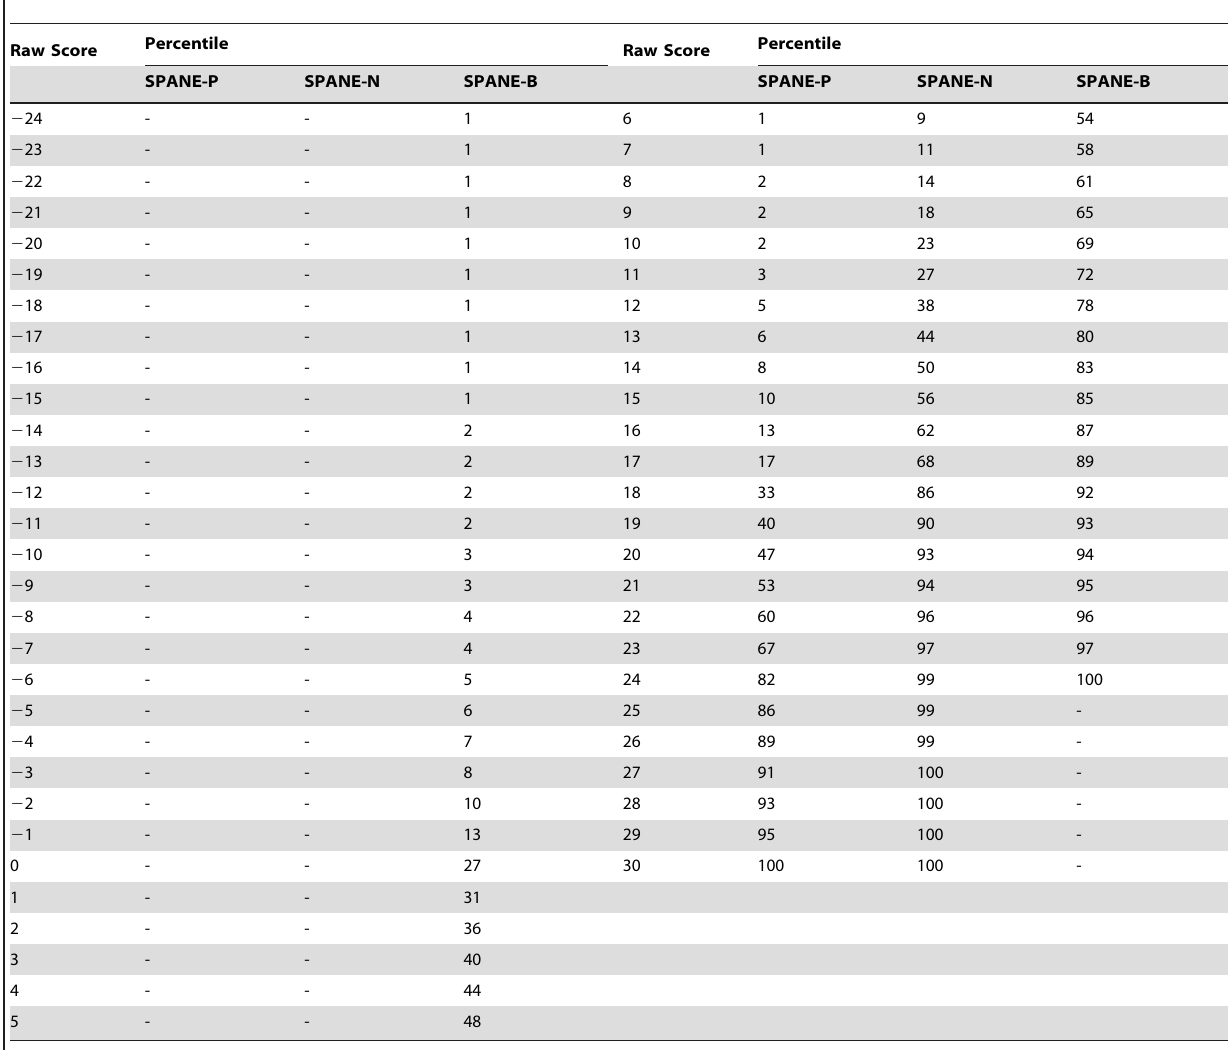
Table 7. SPANE scale norms in terms of percentile rankings.